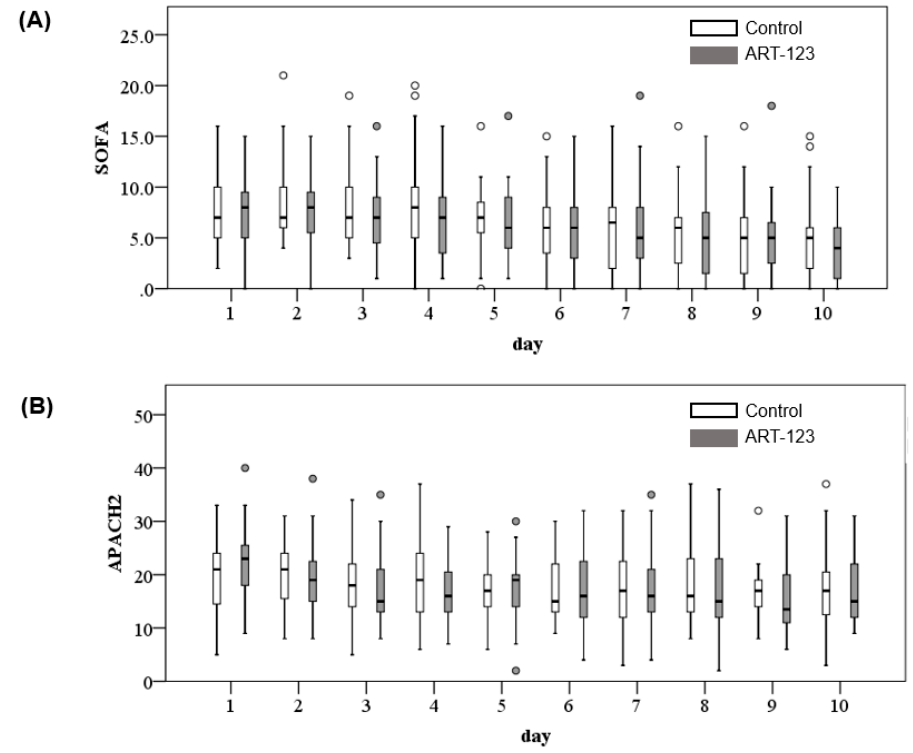
Figure 1. Changes of time course in SOFA ( A ) and APACHE II ( B ) scores from day 1 to day 10. As a marker of inflammation, CRP values were measured from day 1 to day 10. Although CRP values were significantly improved in both groups at day 10, there was no significant di ff erence between the ART-123 and control groups ( p = 0.071, Figure